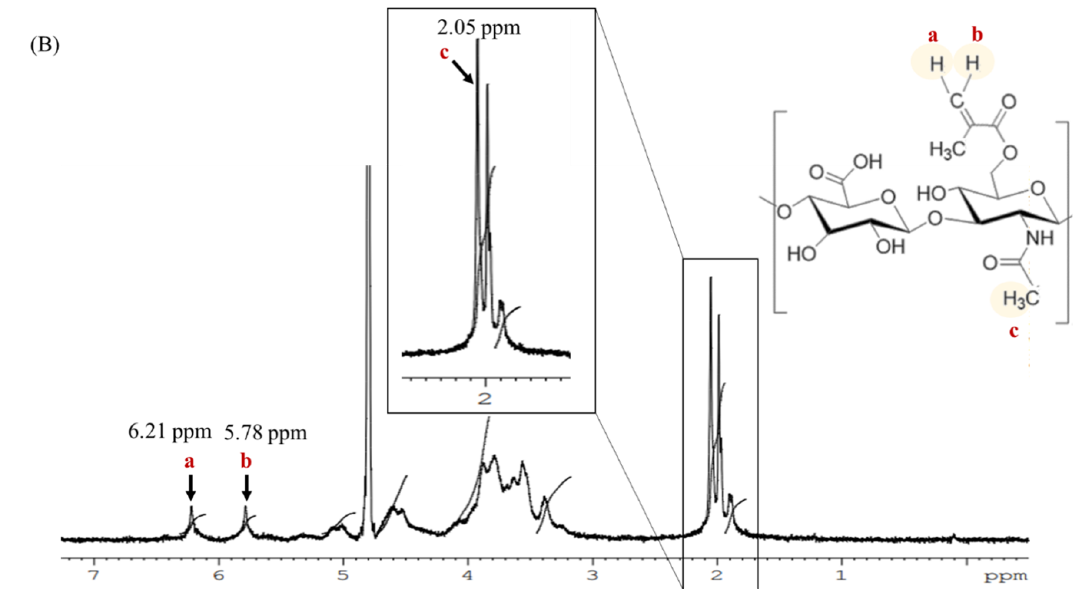
Figure 2. FTIR spectra ( A ) and 1 H NMR spectra ( B ) of hyaluronan (HA) and methacrylate-hyaluronan (MHA).